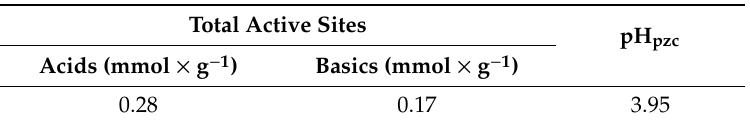
Table 2. Quantification of the total acidic and basic groups on the surface of the coffee pulp (CP) and zero charge potential (pH pzc ).